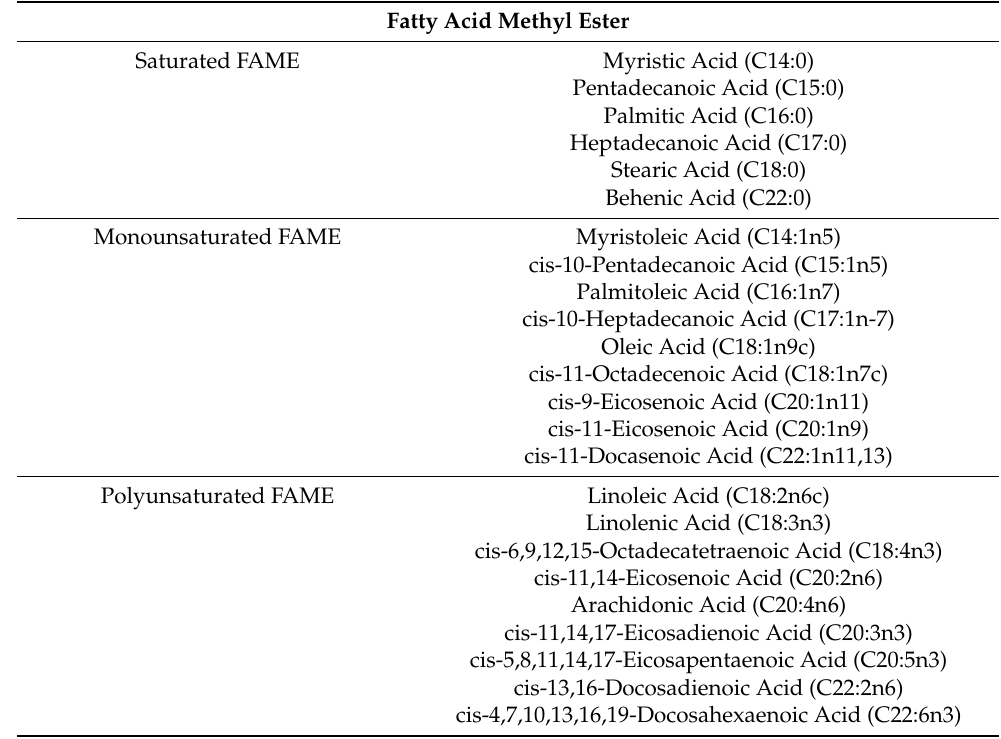
Table 4. The categories of fatty acid methyl esters derived from squid liver in this study.